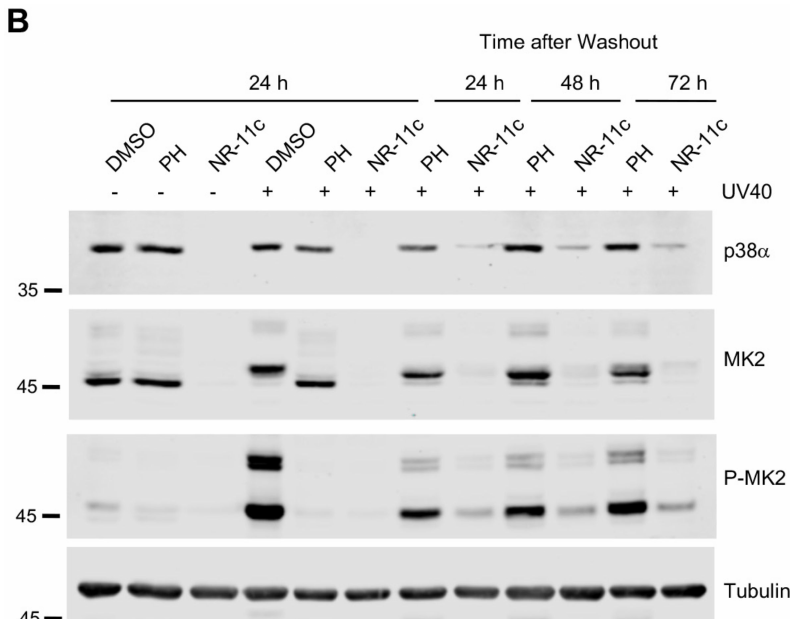
Figure 6. Effect of NR-11c on stress-induced p38 α activation. ( A ) MDA-MB-231 cells were pre-treated with the inhibitor PH-797804 (PH) or the indicated PROTACs at 1 and 0.1 µ M, or with DMSO, for 24 h prior to stimulation with UV-C (40 J/m 2 ). After 1 h, cell lysates were analyzed by immunoblotting using the indicated antibodies. ( B ) MDA-MB-231 cells were pre-treated with DMSO, PH or NR-11c at 1 µ M and 24 h later were stimulated with UV-C. For the washout samples, cells were washed to remove the compounds after 24 h of treatment and then incubated in compound-free media for 24, 48 or 72 h before stimulation with UV-C. In all cases, cell lysates were prepared 1 h after UV stimulation and analyzed by immunoblotting using the indicated antibodies. Experiments were performed with a minimum of n = 2 biological replicates with similar results obtained each time. The uncropped blots are shown in Supplementary Materials File